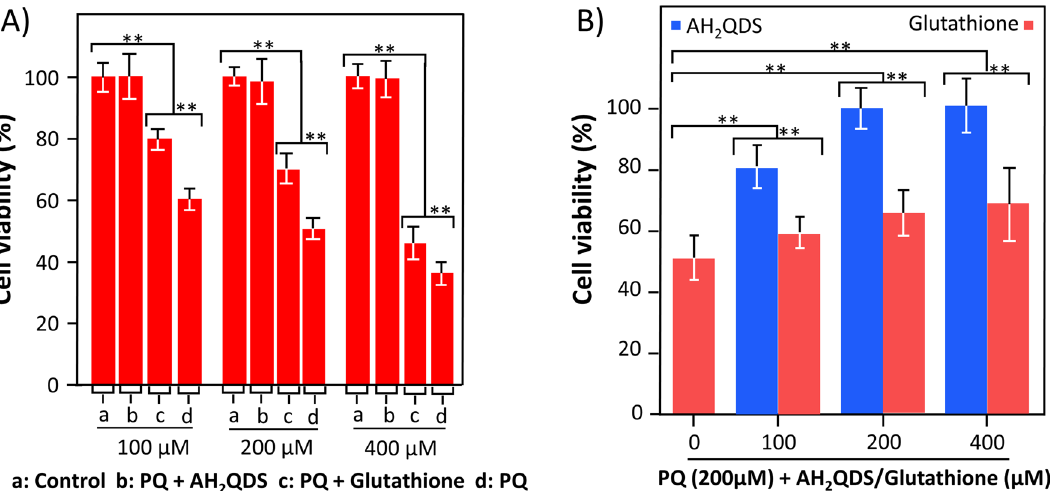
Figure 2. Antidotal effects of AH 2 QDS on PQ poisoning in vitro. ( A ) A549 cells in different treatment groups were incubated at different drug concentrations. ( B ) Viability of A549 cells co-cultured with PQ (200 μM) and various concentrations of AH 2 QDS/Glutathione for 72 h. Data are presented as means ± SEM, n = 3, NS = not significant, *P < 0.05, **P <